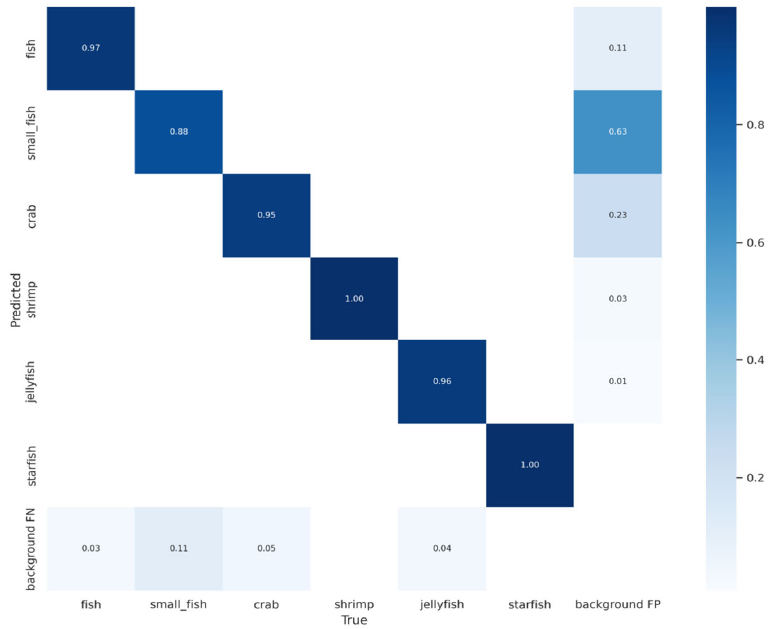
J. Mar. Sci. Eng. 2023 , 11 , x FOR PEER REVIEW Figure 13. The confusion matrix of the YOLOv7-AC model (the Brackish dataset). Figure 13. The confusion matrix of the YOLOv7-AC model (the Brackish dataset).